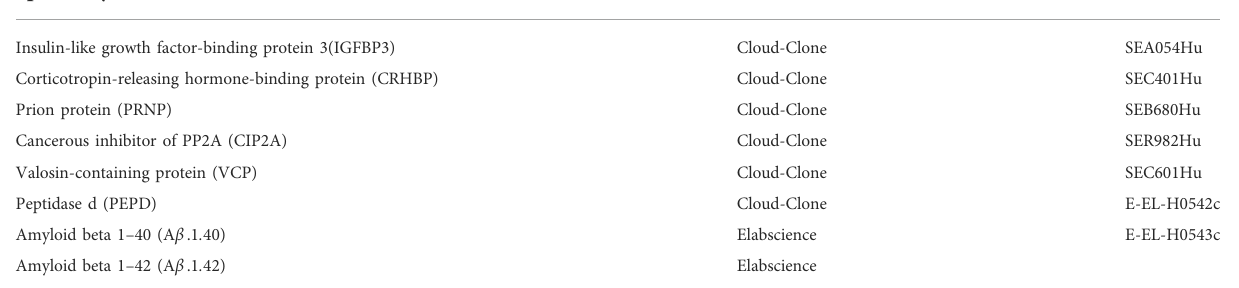
TABLE 2 List of ELISA kit used in the study. Speci fi city CAT.